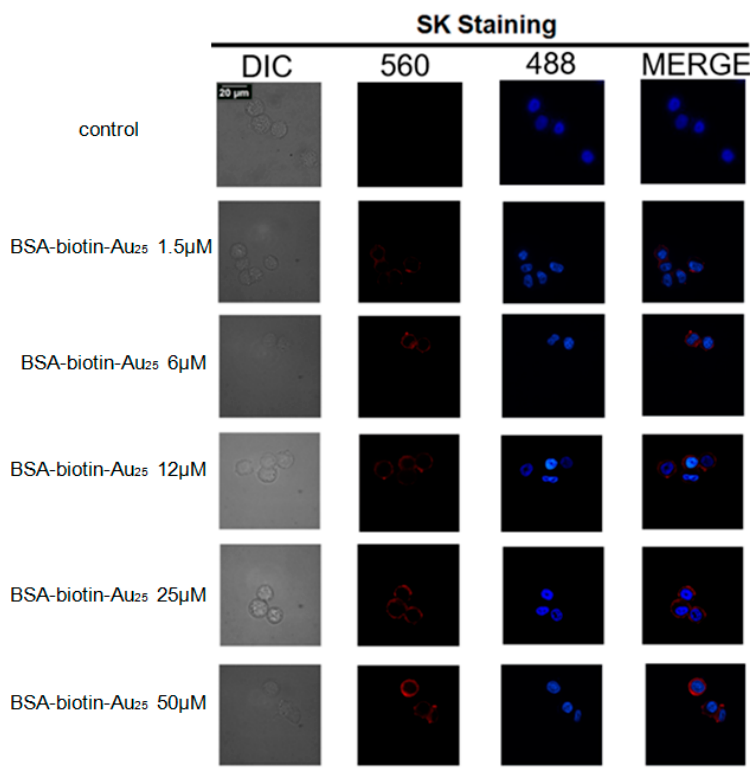
Figure 3. Fluorescence imaging BSA-biotin-Au 25 -labeled SK cells of different concentrations for 45 min. 3.4. Changes in the Expression of HER-2 Protein in Triple-negative Breast Cancer MDA-MB- 231 Cells before and after Paclitaxel Treatment There is almost no HER-2 protein on the triple-negative breast cancer MDA-MB-231 cell membrane, but its expression increased after paclitaxel treatment. As is shown in Fig- ure 4a, the red fluorescence of BSA-Biotin-Au clusters is almost invisible on the MDA-MB- 231 cell membrane, which means that there is almost no HRE-2 protein on it. Only faint bands can be seen in the Western blotting results of MDA-MB-231 cell lines in the control group, which further proves the accuracy of BSA-Biotin-Au clusters to label the HER-2 protein (Figure 4b). However, after a 0.5 μ g/mL paclitaxel treatment for 24 h, the expres- sion level of HER-2 protein significantly increased (Figure 4b). The results of CLSM imag- ing further proved the occurrence in changes in the expression of HER-2 on MDA-MB- 231 cell lines before and after paclitaxel treatment. Moreover, the expression of HER-2 on MDA-MB-231 cells was further verified using a BSA-Biotin-Au 25 cluster probes. As is de- picted in Figure 4c, after treatment with paclitaxel, the MDA-MB-231 cells were labeled by BSA-Biotin-Au 25 clusters and emitted red fluorescence, while there was no fluorescence signal in MDA-MB-231 cells treated with PBS. These results prove that our BSA-Biotin- Au cluster-probe labeling method is as accurate as the commercial antibody immunoblot- ting method, noting that the immunoblotting process is cumbersome. On the other hand, the expression of the HER-2 protein on triple-negative breast cancer MDA-MB-231 cells increases during treatment with the chemotherapeutic drug paclitaxel, which provides a prerequisite for companion diagnoses.